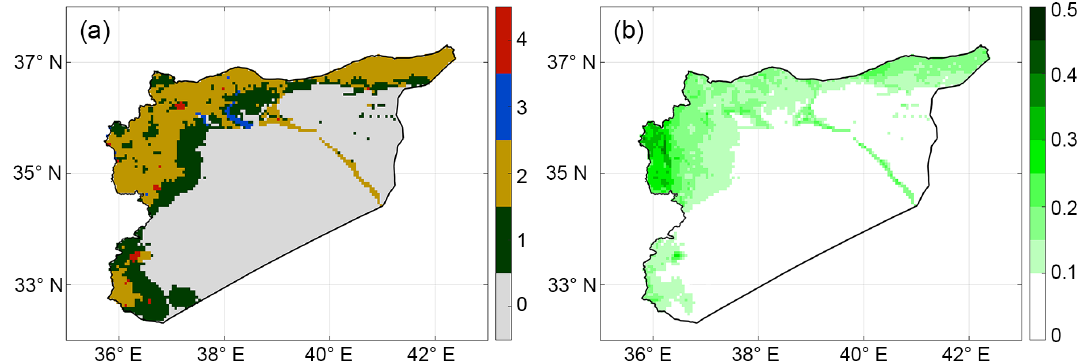
Figure 1. Land cover and vegetation conditions in Syria. (a) Land cover types based on the MCD12C1 data of 2010. Color codes 1–4 indicate the natural vegetation, croplands, water bodies and built-up lands, respectively. 0 represents the unused land, which is colored in gray. (b) The spatial distribution of annual EVI in